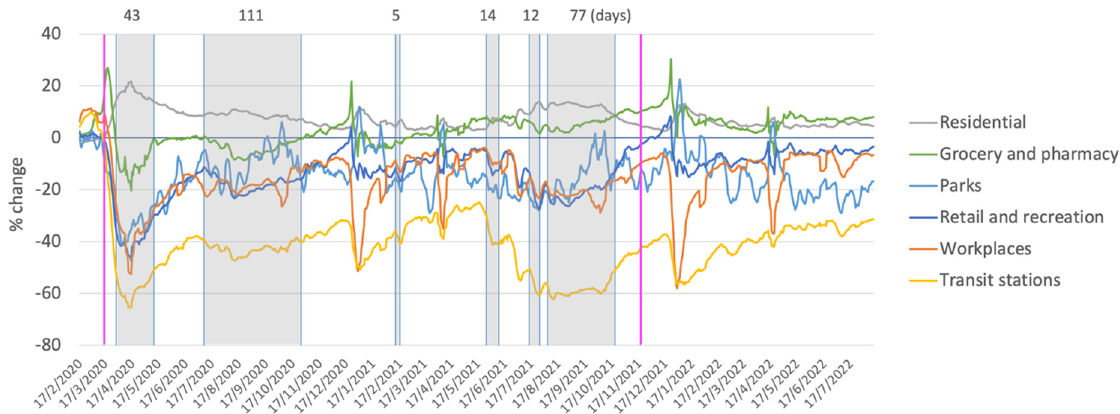
Figure 1. Changes in community movement in specific locations in Australia relative to the period before the COVID-19 pandemic. The ‘Residential’ category shows percent change in duration of time spent at home; the other categories measure a change in total visitors (compared to baseline days: the median value for the 5-week period from 3 January to 6 February 2020). First (16 March 2020) and last (19 November 2021) days of restrictions are indicated by magenta reference lines. Shaded areas represent Melbourne lockdowns. The duration of each lockdown (in days) is indicated above each lockdown period (Note: Mandatory COVID-19 isolation periods ended in Australia on 14 October 2022). Source: Google COVID-19 Community Mobility Trends–last updated 16 August 2022 (https://www.google.com/covid19/mobility/ accessed on 18 August 2022).